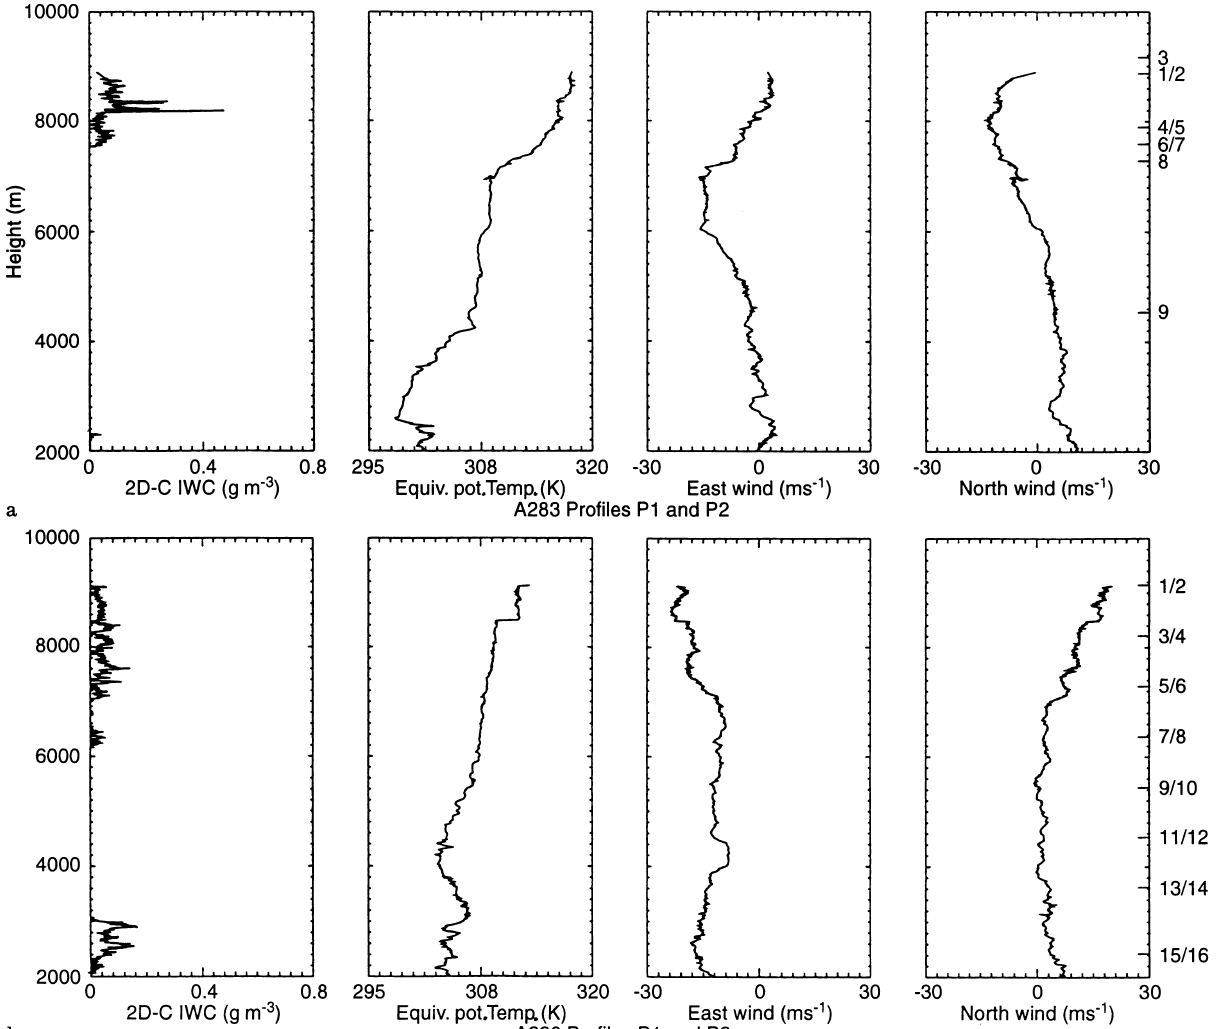
of the last profile. b Conditions encountered during flight A290. The discontinuity at 8.5 km in the profiles is due to combining the main profile with a shorter one at higher levels. The height at which each run was flown is marked on the right-hand axis of the last